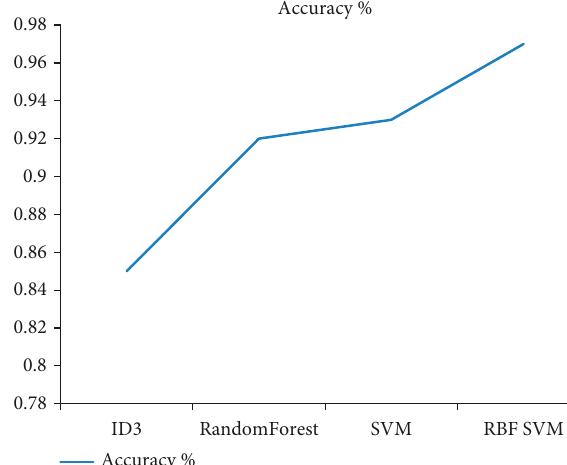
Figure 2: Accuracy results of machine learning algorithms.